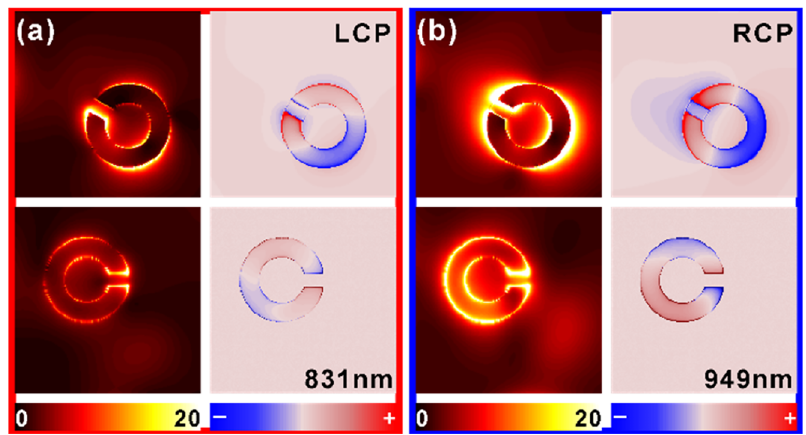
magnetic resonance wavelength is far away from the RAs, there is no diffraction coupling between unit cells. As a result, the CD response of the array is almost identical to that for an ensemble of the same number of single SRR dimers without diffraction coupling (lower panel, Figure 5). The maximum CD in transmission is only about 0.12, and it is in accordance with the experimental results reported in previous studies [93]. Considering that the magnitude of differential absorption cross sections for the hybridized magnetic dipole resonances are comparable with that of the ABDQ and BDQ modes (Figures 2 and S4), the excitation of SLRs can be an effective approach for enhancing the intrinsic CD responses.